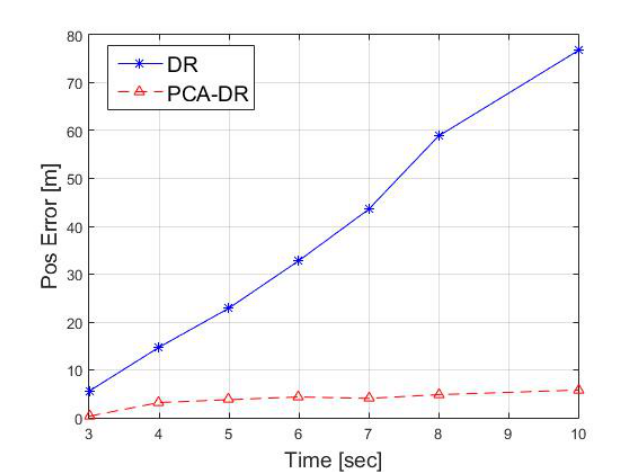
Figure 13. Position error results from the sea experiment comparing PCA-DR with the traditional DR